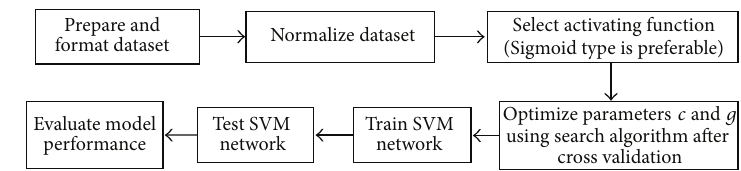
Figure 3: Flow chart of SVM algorithm on predicting classification.